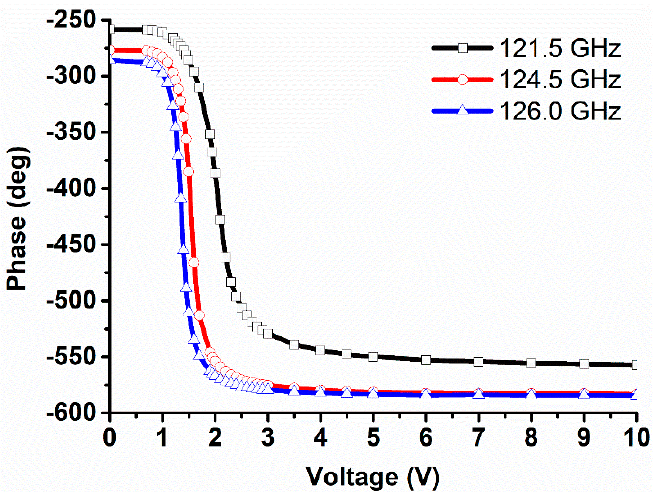
Figure 11. Tunable phase shift as a function of the applied voltage.